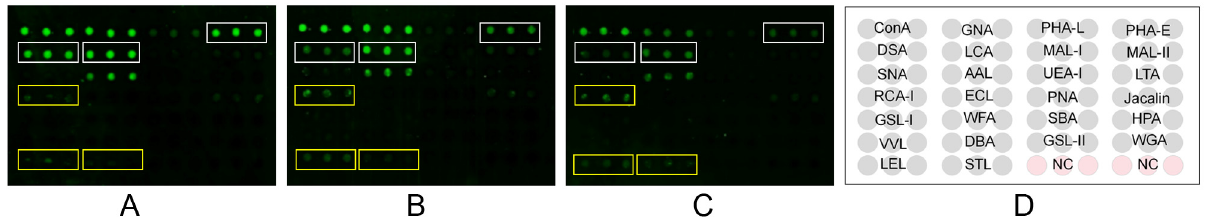
Figure 4. Scans of the lectin microarray. ( A ) Normal control group. ( B ) HP-PRRSV HN-infected group. ( C ) HP-PRRSV JXA1-infected group. ( D ) The layout of the lectin microarray (see Table S1 for full names). Each lectin was spotted in triplicate per block. Yellow frames and white frames marked indicated the lectin sites significantly increased and decreased compared to the normal control group, respectively. The negative controls showed no positive signal. NC: negative control.